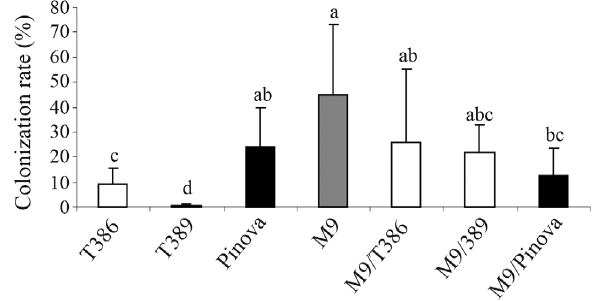
Figure 6 - AMF colonization rates of greenhouse-grown transgenic lines (T386 and T389) and non-transgenic Pinova (on own roots and grafted on rootstockM9)inthesecondyearofcultivationinsand-vermiculitewith G. intraradices and G. mosseae. The columns represent the mean (cid:3) SD of ninedeterminations.ANOVAoflogtransformeddatarevealedsignificant differences among the varieties/lines (F: 15.3322, p < 0.0001). Different letters above bars indicate significant differences (p < 0.05) based on Tukey’s Honestly Significant Difference test.